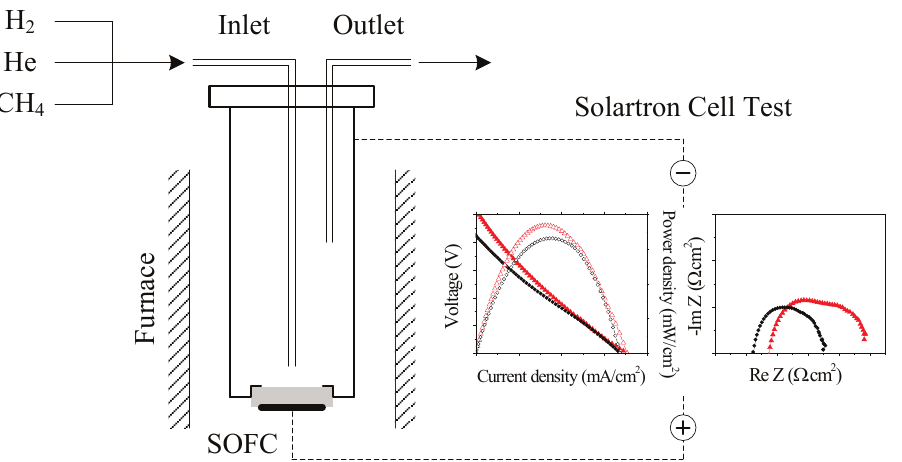
Figure 11. Solid oxide fuel cell (SOFC) testing